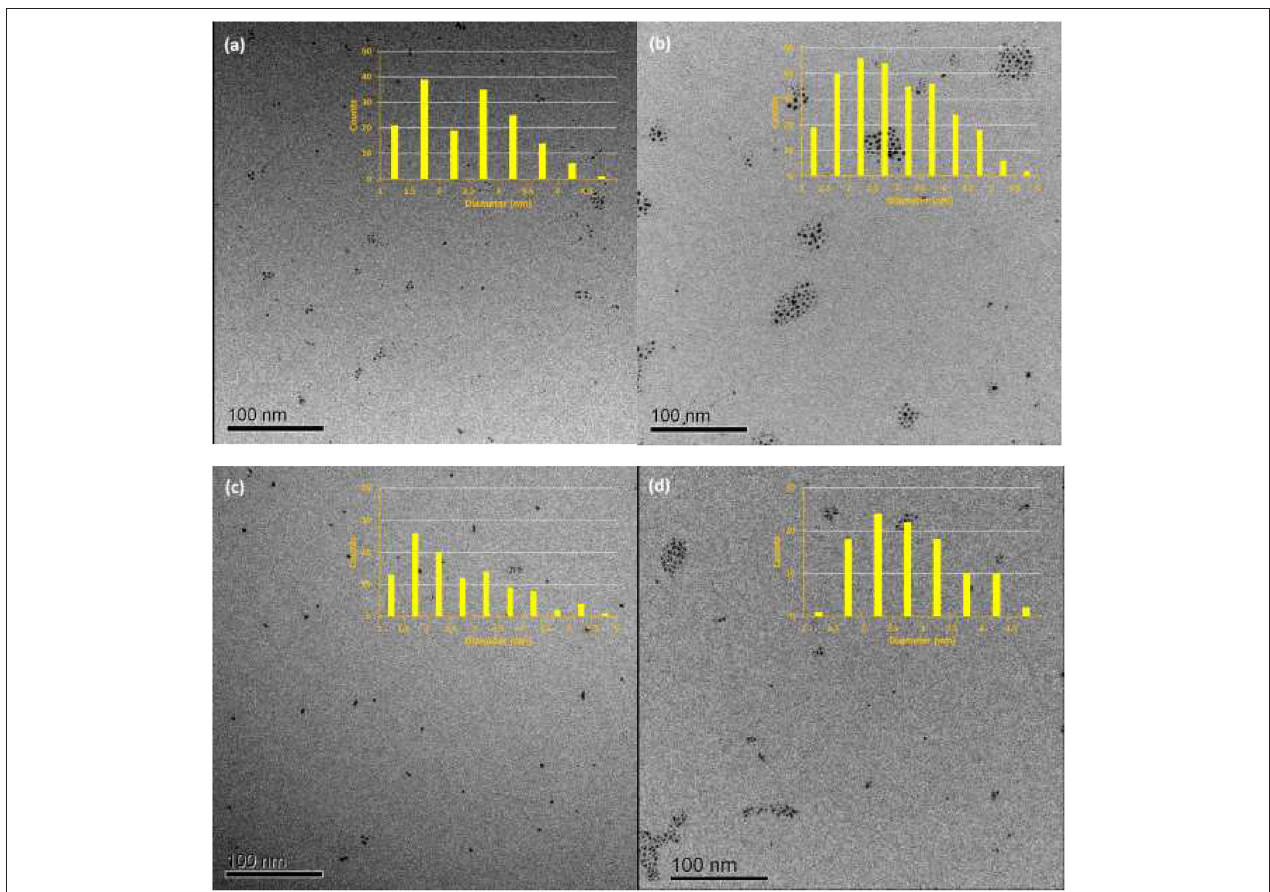
FIGURE 2 | TEM images and histograms of four synthesized palladium nanoparticles: (a) PdNP, (b) PdNP α , (c) PdNP β , and (d) PdNP γ .